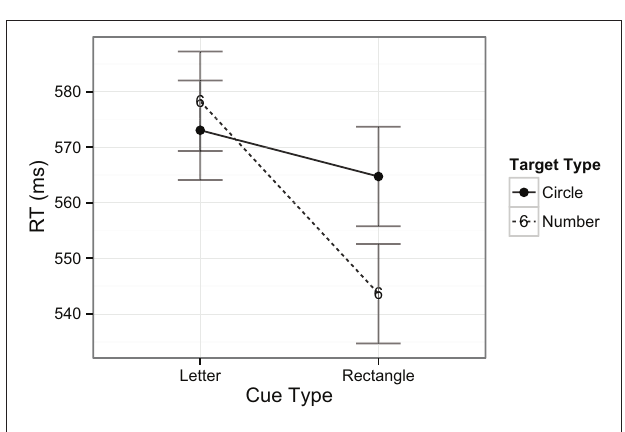
FIGURE 9 | Mean RTs across tasks and cue